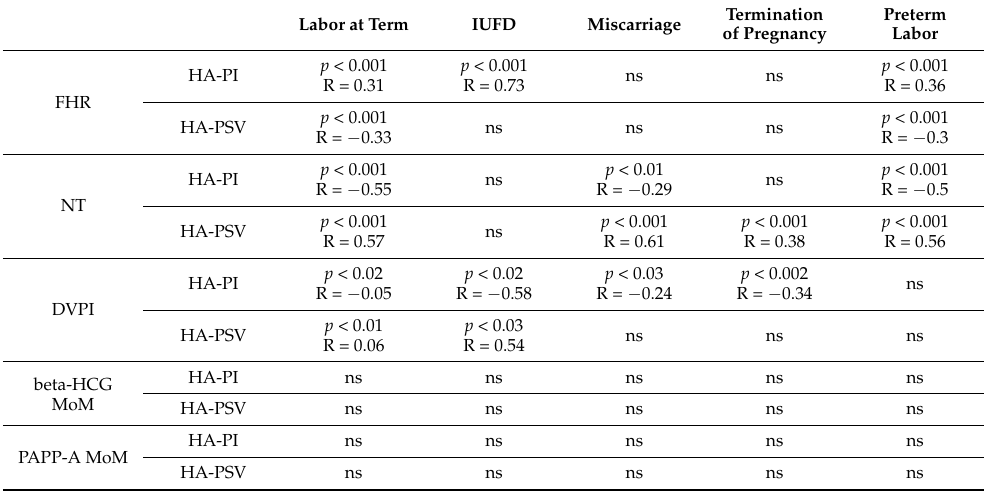
Table 7. Correlations between hepatic artery flows and selected first-trimester screening parameters depending on the pregnancy outcome (ns = not